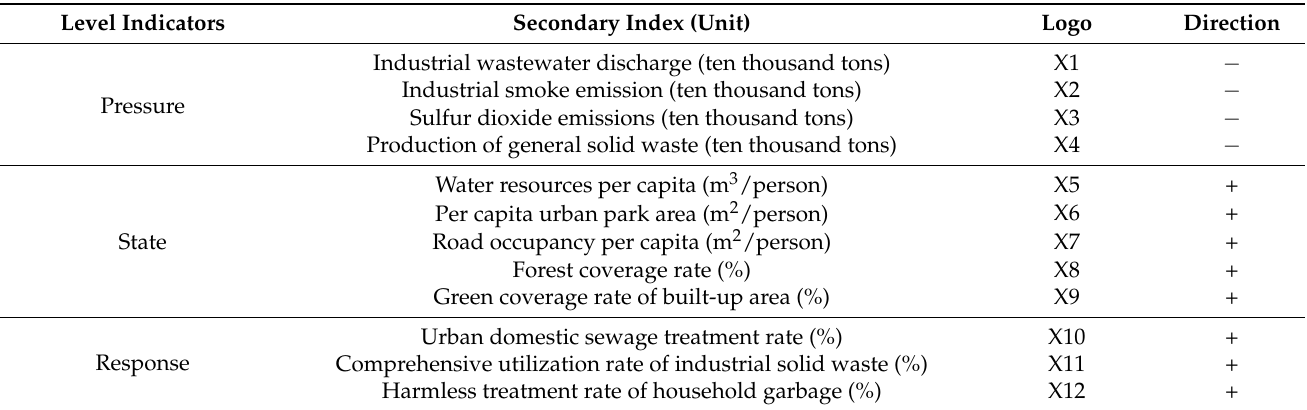
Table 1. Index system of eco-environmental